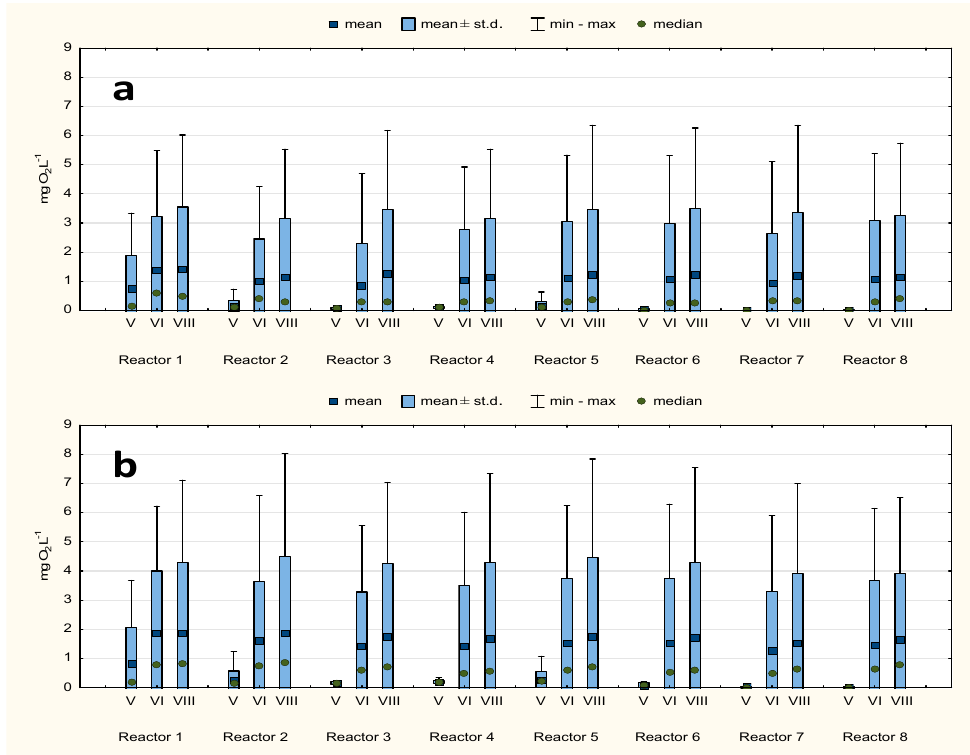
Figure 4. Changes in oxygenation of the waters of Lake Łajskie at a depth of 0.5 m ( a ) and 1.0 m ( b ) above the bottom level.